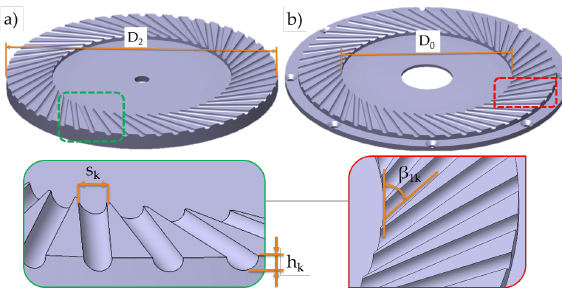
Figure 2: The geometry of the tested set (3D model): a) active disc, b) passive disc. Description of the geometrical parameters: D 2 – outer diameter, D 0 – diameter of the entry to grooves, s k – width of the grooves, h k – depth of the grooves, β 1 k – inlet angle of